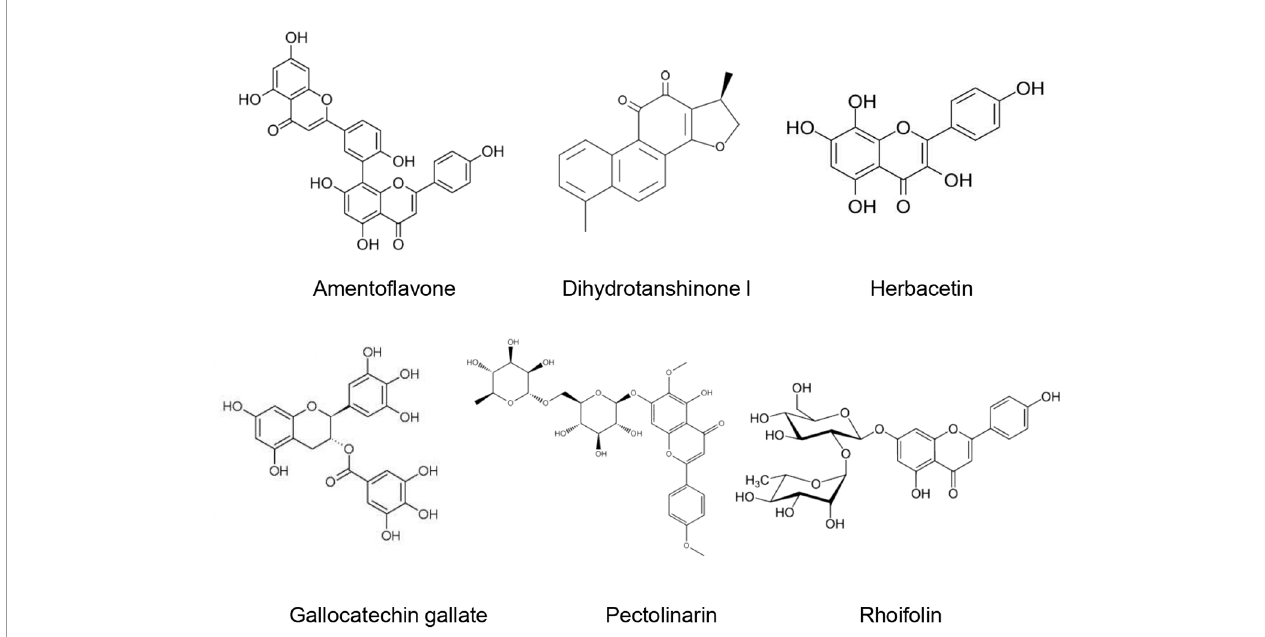
FIGURE 5 | Natural products that act as inhibitors of